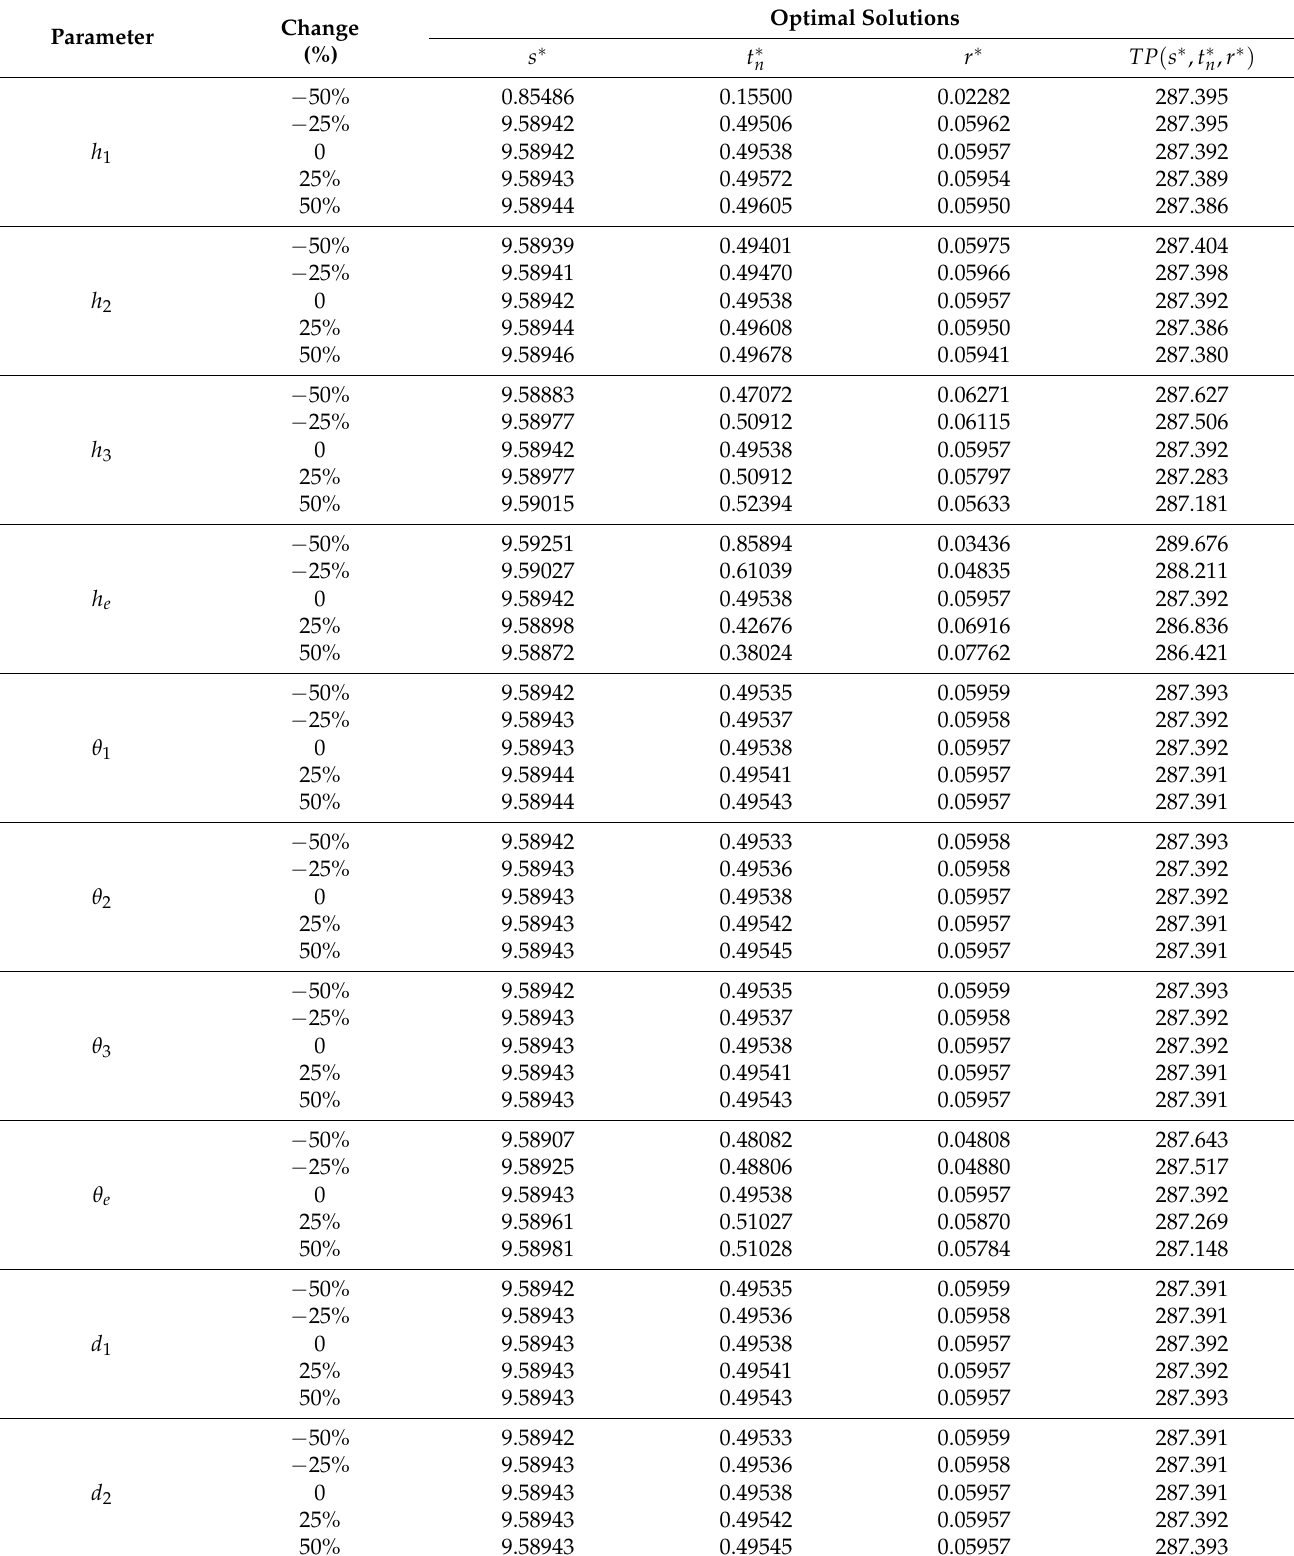
Table A1. Effect of changes in various parameters of the model for application